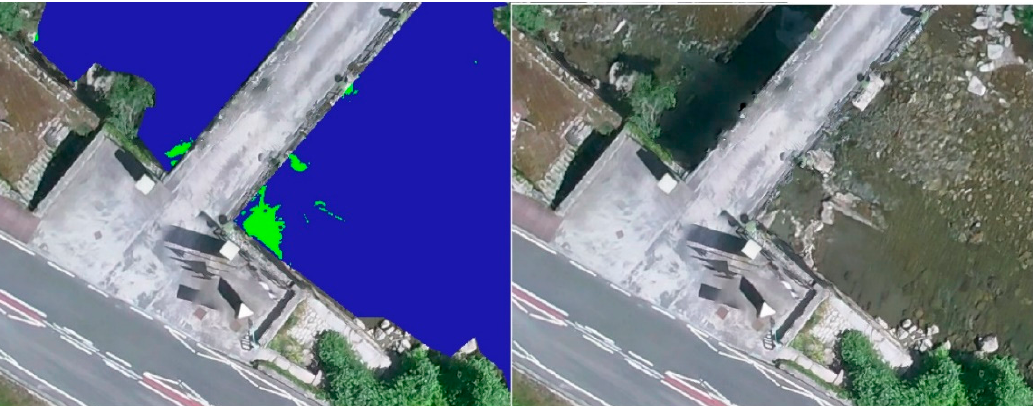
Figure 14. Reclassification detail and RGB orthomosaic zoom of the area of potential interest. The image allows assessing that an area of potential interest corresponds to the surface of a water body, although it is still necessary to check the temperature in the field.